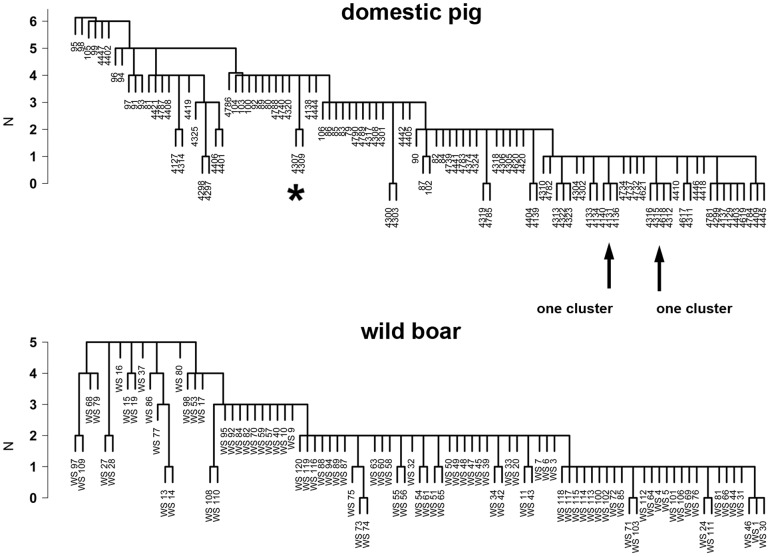
Cluster analysis with virulence-associated genes (VAGs).Isolates from domestic pigs (n = 104) and from wild boars (n = 93) were clustered according to 9 VAGs typical for E. coli isolated from diarrheic pigs (iVAGs) and 37 VAGs typical for E. coli isolated from extraintestinal disease (eVAGs). Using the manhattan distance measure the distance between strains was computed including a hierarchical cluster analysis using a single linkage method (“friends of friends”) clustering strategy. The minimal difference in the number (N) of genes between clusters of strains to other clusters is described. All isolates of one cluster have identical VAG pattern. Distance of 1 (δN = 1) means that two clusters differed at least in one gene. Clusters which included at least four isolates, which were not different in more than 2 genes, were used to associate virulence gene profiles with adhesion rates or a probiotic effect. There were no associations between a specific cluster and adhesion or a probiotic effect. *: Clustered isolates are identified by strain numbers.